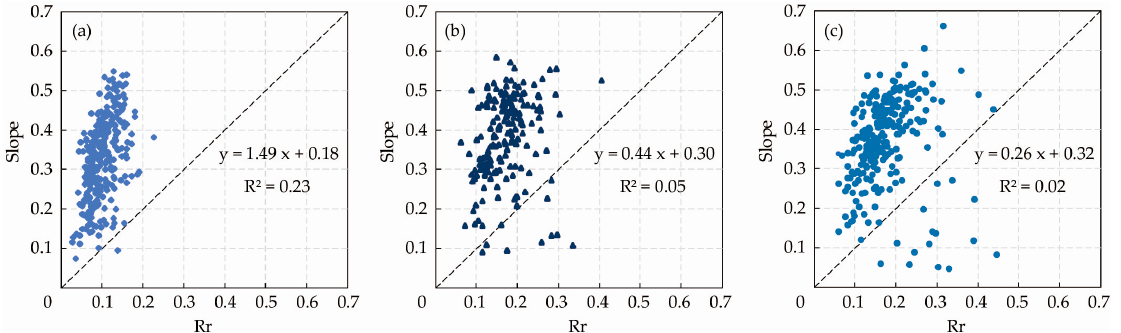
Figure 10. Scatter plot of the Rr versus slope values for the DFP types. ( a ) Water-flood; ( b ) Debris-flood; and, ( c ) Debris-flow.